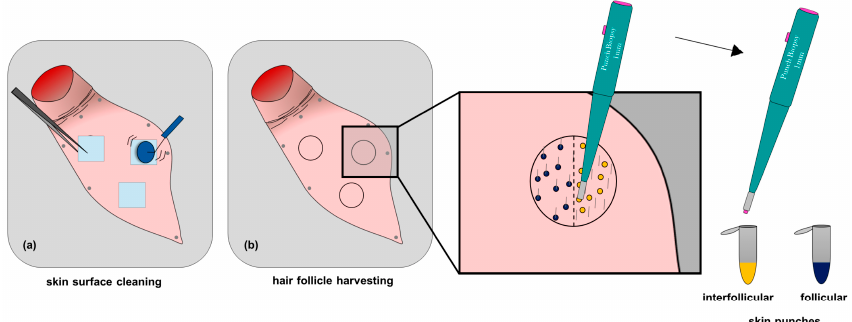
Scheme 1. Graphic illustration: targeted follicular transport study of TFB in a pig ear model ( a ) skin surface cleaning by means of tape stripping and ( b ) follicular and interfollicular skin harvesting by 0.785 mm 2 punch biopsies by means of stereomicroscopy.